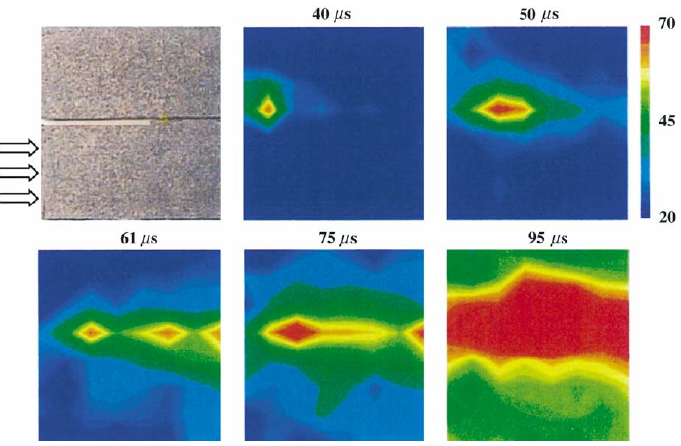
Figure 19. Experimental observations: high-speed infrared images of hot spot formation due to contact behind an intersonically moving shear crack. The top-left image shows the size of the exposed area. The following images show contours of a constant temperature at different time steps